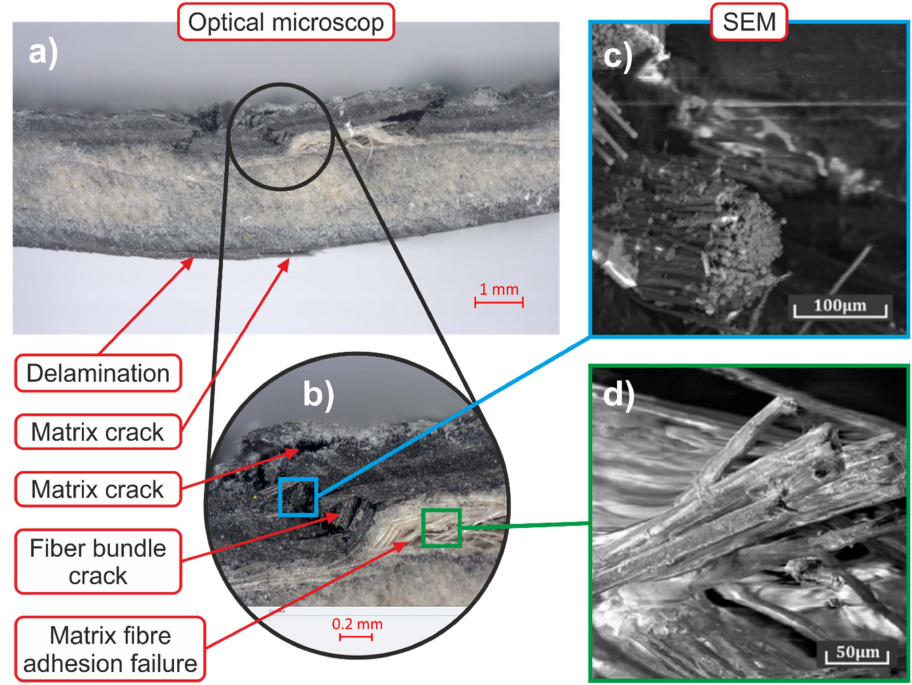
Figure 15. Microstructure of cracked flexural test sample—optical microscopy and SEM analysis, ( a ) side view, ( b ) detail of compressive stress area, ( c ) SEM image of carbon bundle, ( d ) SEM image flax